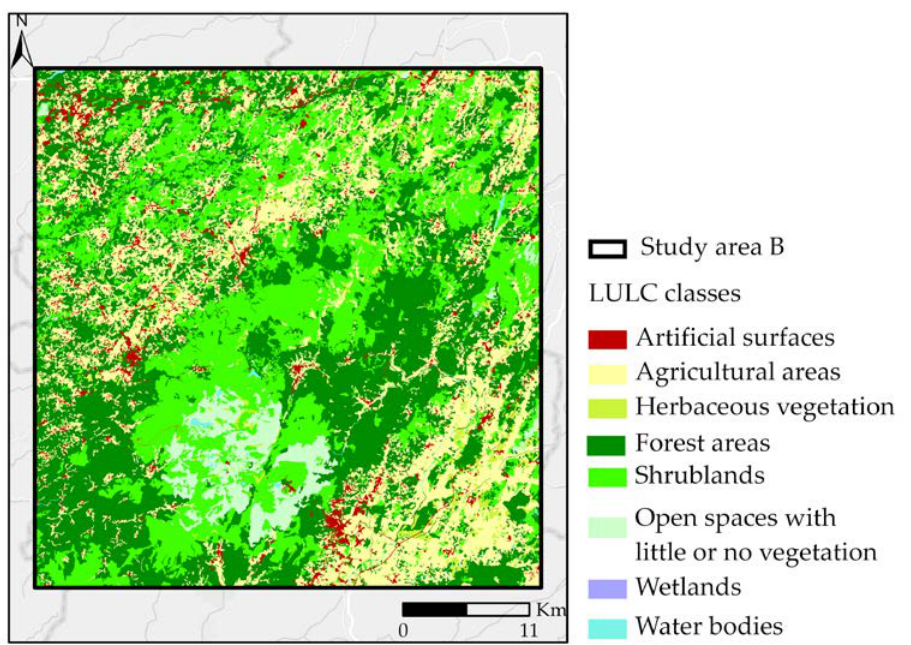
Figure 5. Maps resulting from the conversion of COS 2018 to the classes used in the classification (shown in Table 4) for study area B.